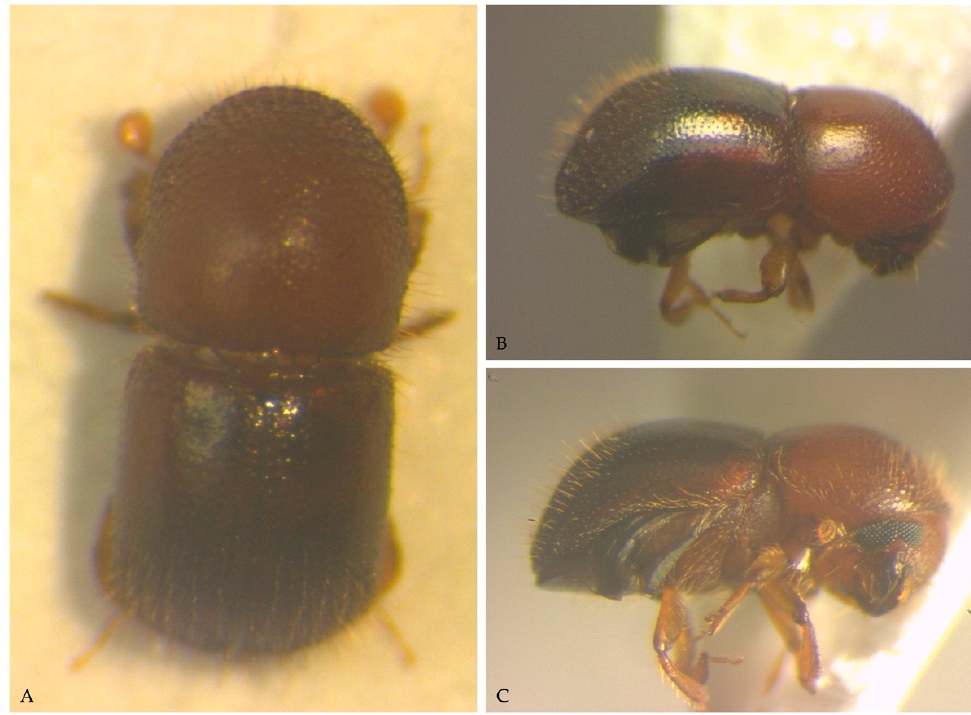
Figure 1. Xylosandrus crassiusculus , specimens collected from galleries on areca nuts: ( A ) dorsal view, alive specimen; ( B ) lateral view; ( C ) ventro-lateral view.